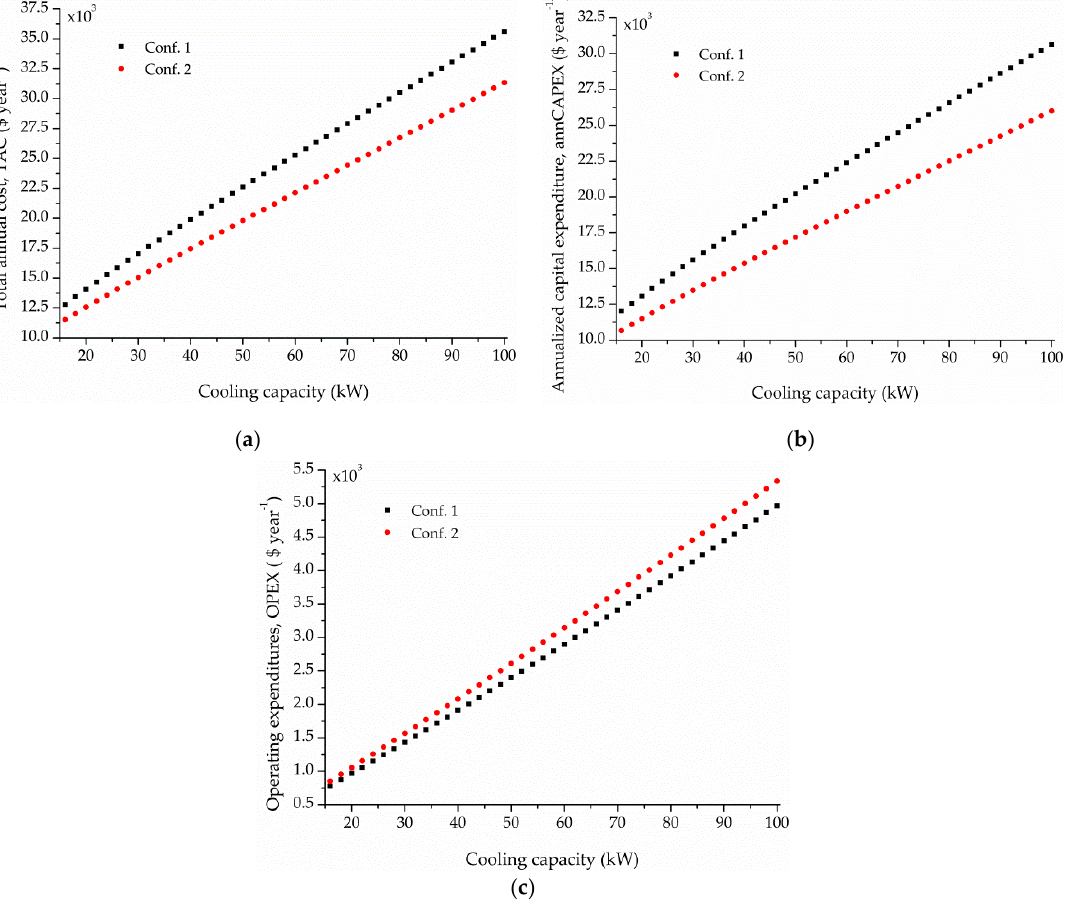
Figure 8. ( a ) Optimal total annual cost (TAC); ( b ) Optimal annualized capital expenditures (annCAPEX); ( c ) Optimal operating expenditures (OPEX) for configurations Conf. 1 and Conf. 2 as a function of the cooling capacity level.